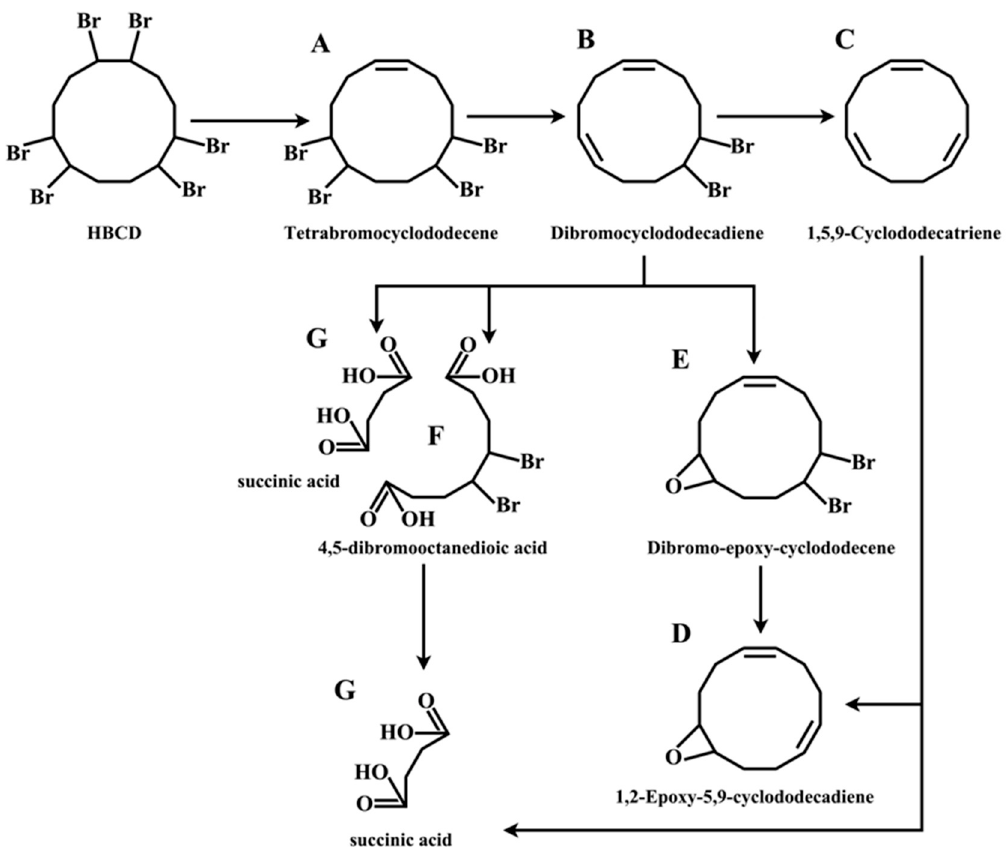
Figure 7. Possible pathways of degradation of HBCD in UV/TiO 2 /KPS systems.